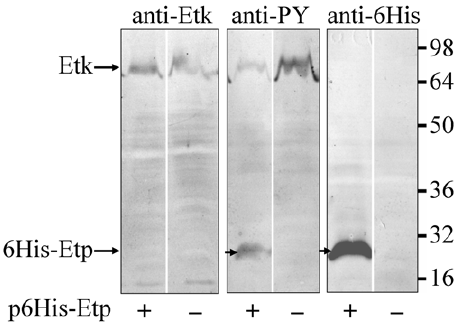
Figure 2. Etp promotes Etk dephosphorylation and is tyrosine phosphorylated in vivo . EPEC strains transformed, or not trans- formed, with plasmid pAP406 (p6His-Etp) expressing 6His-Etp, were grown overnight in LB at 20 u C without shaking. The bacteria were harvested, and the extracted proteins were separated for Western blot analysis with anti-Etk, anti-phosphotyrosine (anti-PY), and anti-6His antibodies. The corresponding antibody is indicated above each panel. Also indicated are the location of Etk and 6His-Etp and the molecular size markers (at the right). Whether a given strain contained the pEtp plasmid is indicated below each lane.